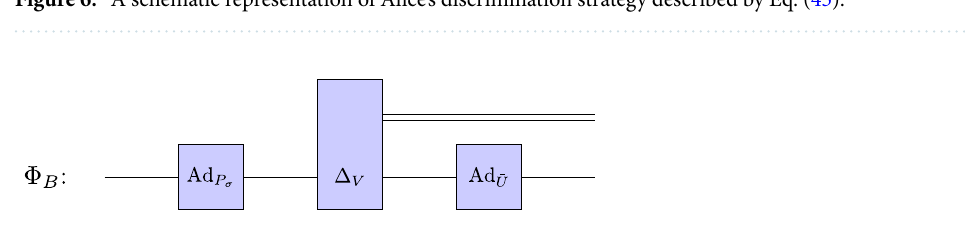
Figure 6. A schematic representation of Alice’s discrimination strategy described by Eq. (45).